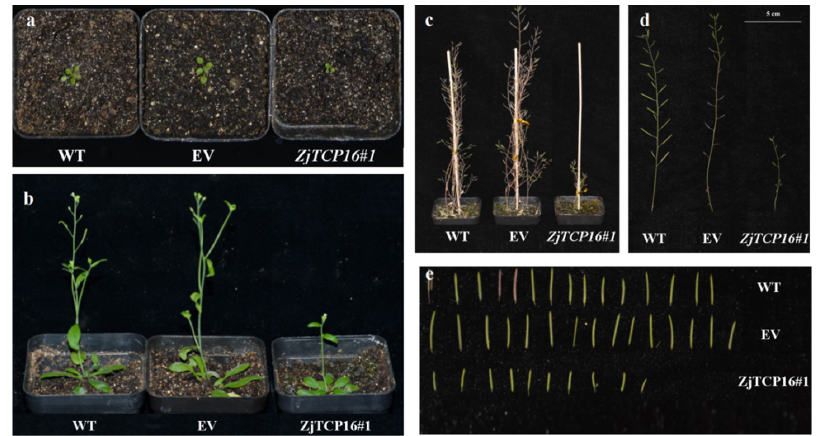
Figure 3. Overexpression of ZjTCP16 in Arabidopsis induced phenotype of dwarfism and reduced leaf size. ( a ): Phenotypes of wild-type Arabidopsis, empty vector (EV) and ZjTCP16 -OE lines at 1 week after transfer (WAT) from germination medium. ( b ): Phenotypes of wild-type, EV and ZjTCP16 -OE Arabidopsis at 3WAT. ( c ): Phenotypes of wild-type, EV and ZjTCP16 -OE Arabidopsis at 5WAT. ( d ): Bolts of WT, EV and ZjTCP16 -OE Arabidopsis at 5WAT; ( e ): Morphological observation of siliques of WT, EV and ZjTCP16 -OE Arabidopsis at 5WAT.